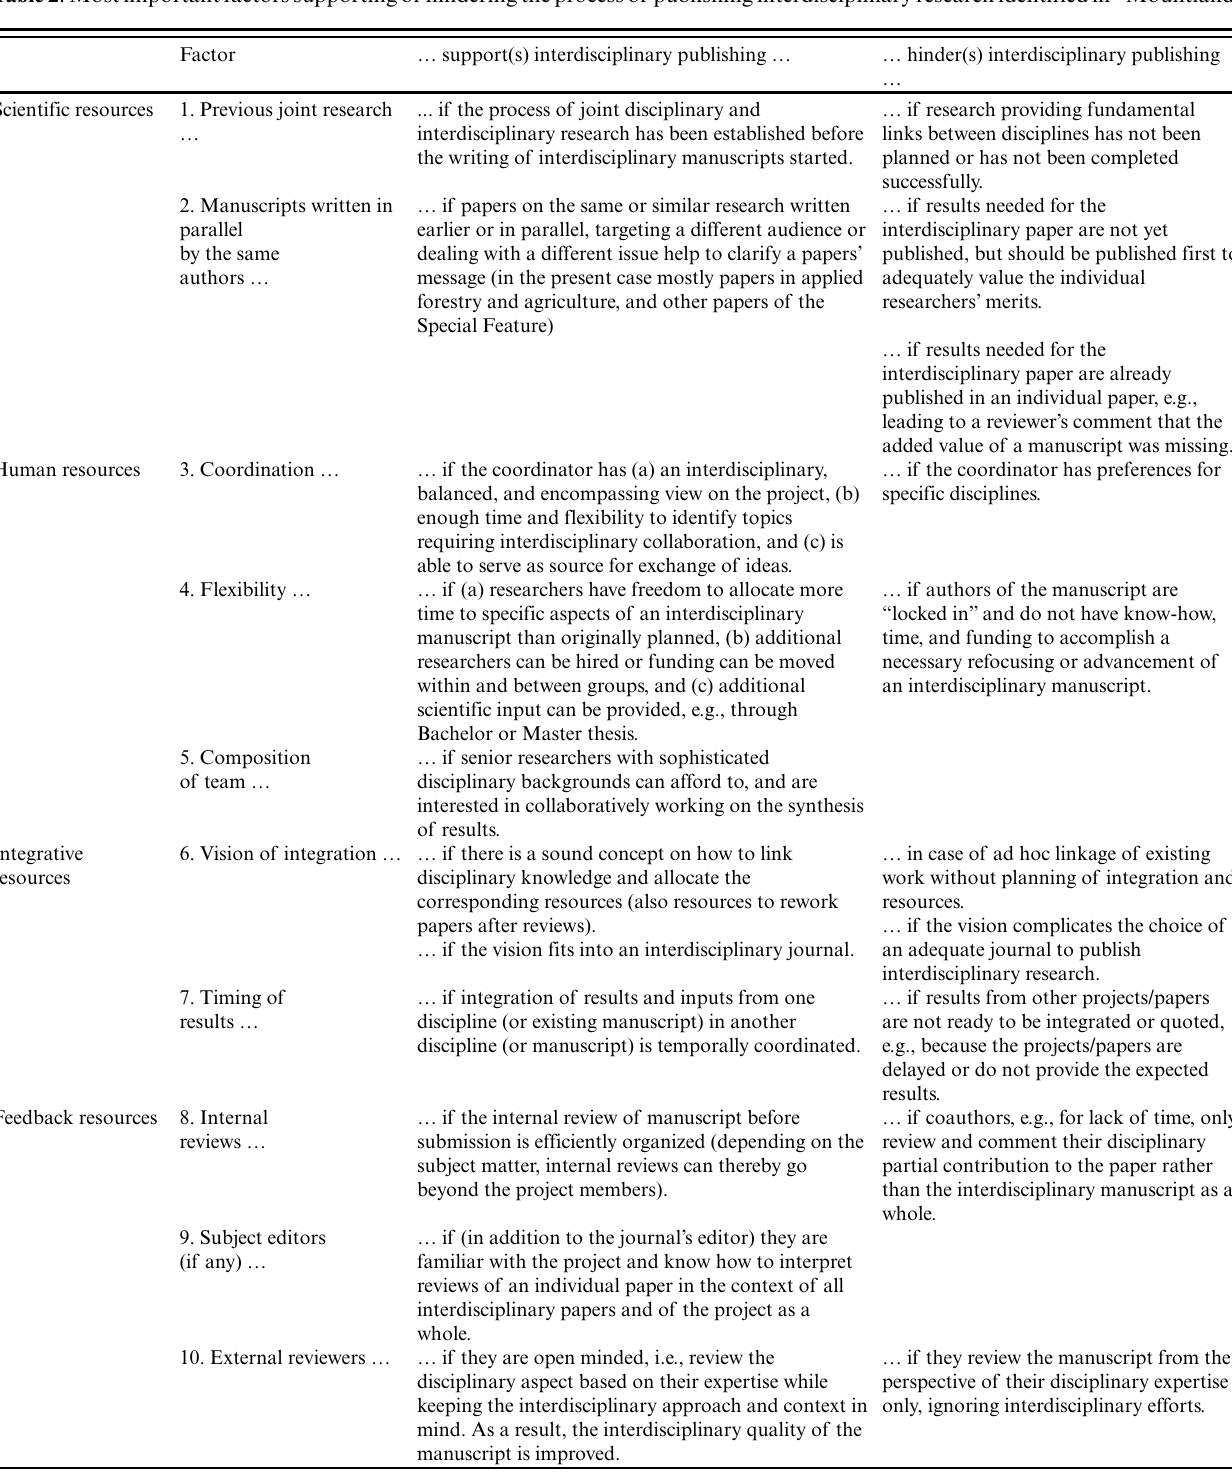
Table 2 . Most important factors supporting or hindering the process of publishing interdisciplinary research identified in “Mountland.”